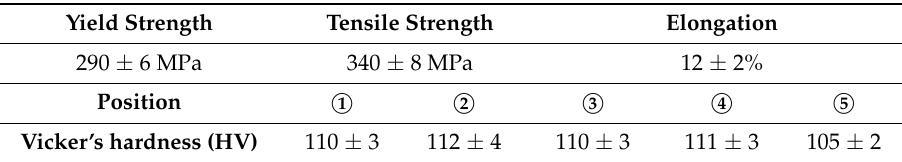
Table 1. Mechanical properties of produced final part